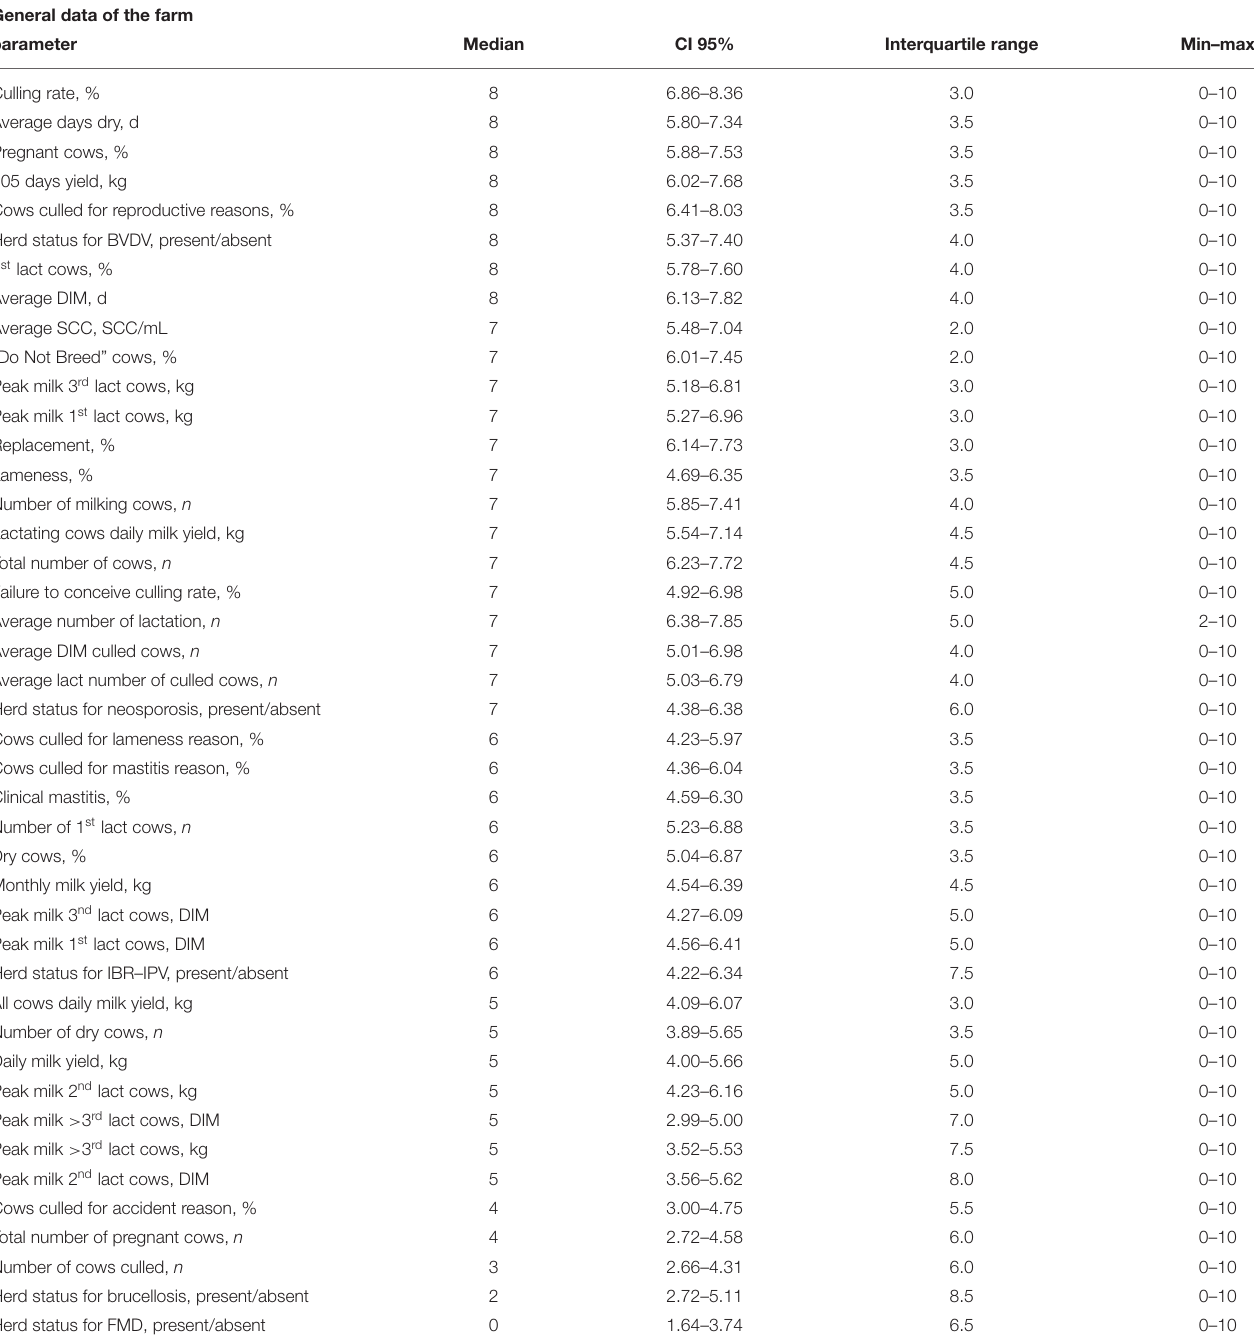
TABLE 1 | Answers given by consultants about farm general parameters, where 0 is of minimal or irrelevant importance and 10 represents the maximum importance. General data of the